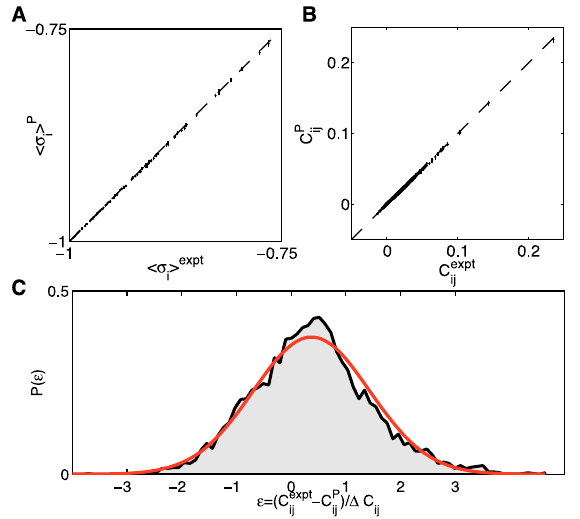
Figure 3. Reconstruction precision for a 100 neuron subset. Given the reconstructed Hamiltonian of the pairwise model, we used an independent Metropolis Monte Carlo (MC) sampler to assess how well the constrained model statistics (mean firing rates ( A ), covariances ( B ), plotted on y-axes) match the measured statistics (corresponding x- axes). Error bars on data computed by bootstrapping; error bars on MC estimates obtained by repeated MC runs generating a number of samples that is equal to the original data size. ( C ) The distribution of the difference between true and model values for * 5 : 10 3 covariance matrix elements, normalized by the estimated error bar in the data; red overlay is a Gaussian with zero mean and unit variance. The distribution has nearly Gaussian shape with a width of < 1.1, showing that the learning algorithm reconstructs the covariance statistics to within measurement